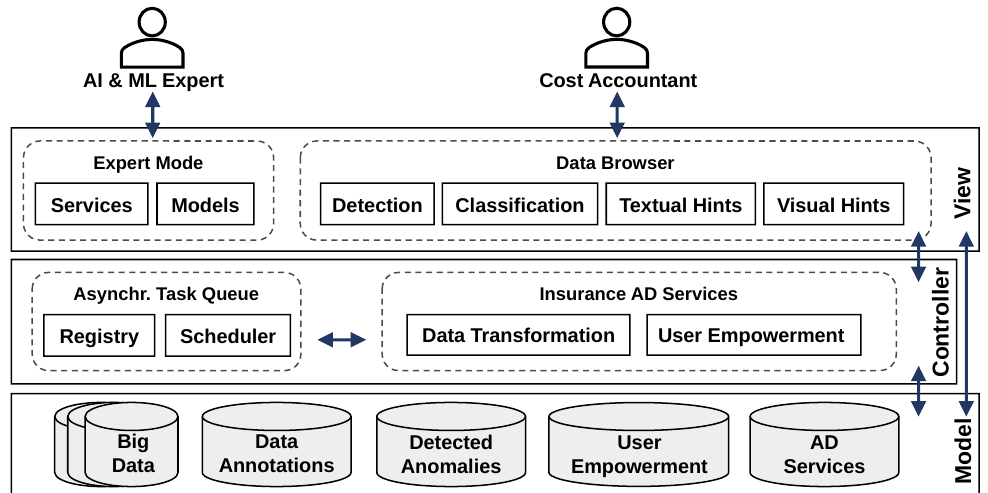
Figure 8. Simplified MVC architecture.